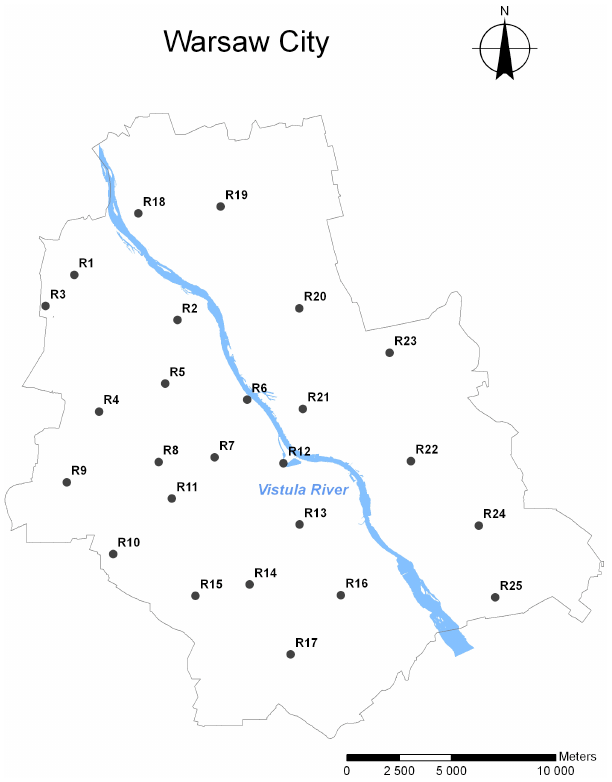
Fig. 1. Location of rain gauges used in study in Warsaw,